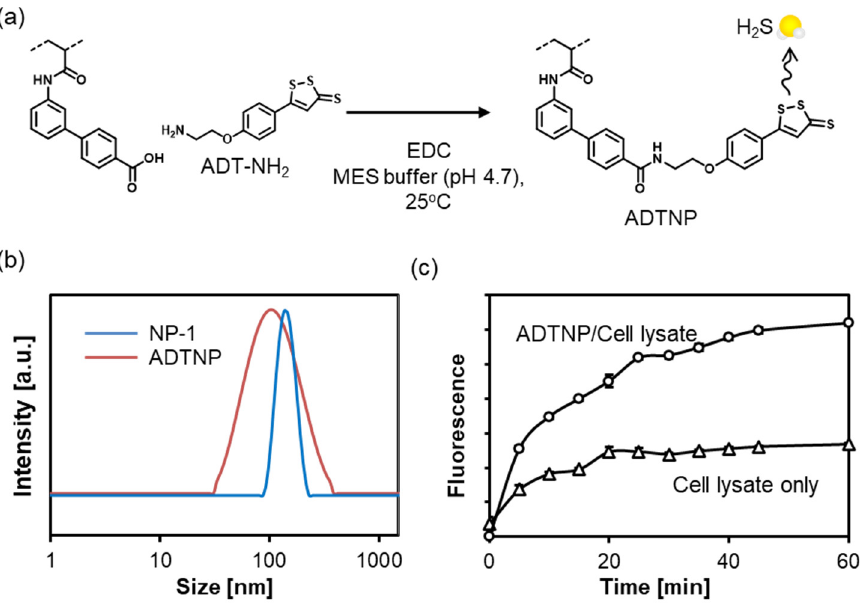
Figure 4. H 2 S donor ADT ‐ conjugated nanoparticles (ADTNP). ( a ) Conjugation of a H 2 S donor ADT ‐ NH 2 with NP ‐ 1 via EDC coupling. ( b ) Size distribution before (NP ‐ 1) and after conjugation (ADTNP). ( c ) H 2 S release from ADTNP in cell lysate as detected by the WSP ‐ 1 H 2 S detection dye.